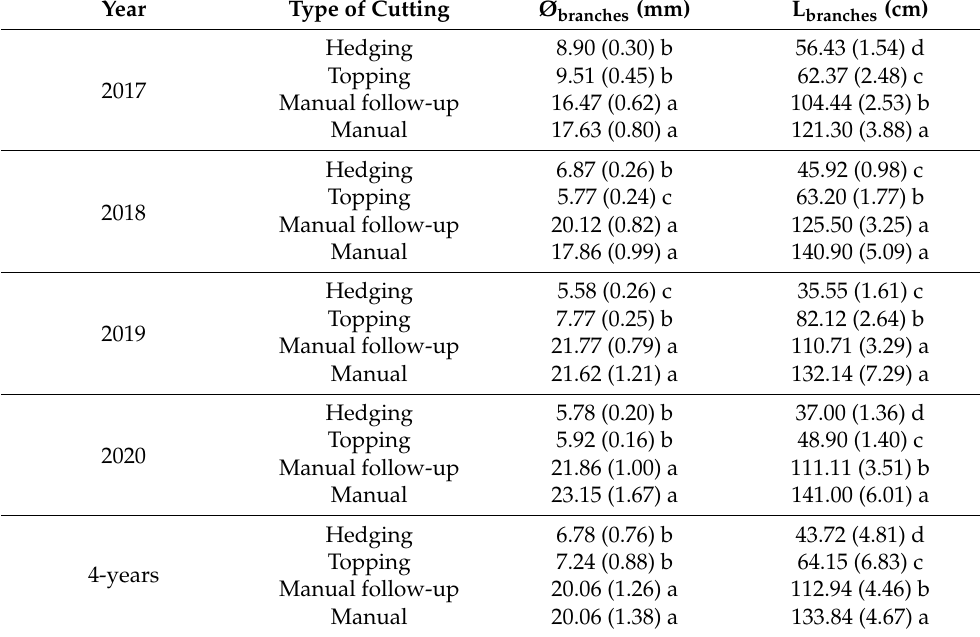
Table 5. Diameter of the cutting area (Ø branches , mm) and length (L branches , cm) of cut branches by type of cutting, for each year and for the four years overall. Branches were chosen from pruning strategies in which there was no annual alternation between manual and mechanical pruning. Data are expressed as averages, with standard errors in parentheses. Different letters between types of cutting for Ø branches and L branches indicate significant differences ( p < 0.05) according to the median notched box plot for each year 1 and according to Fisher’s LSD test for the 4-year overall 2 .